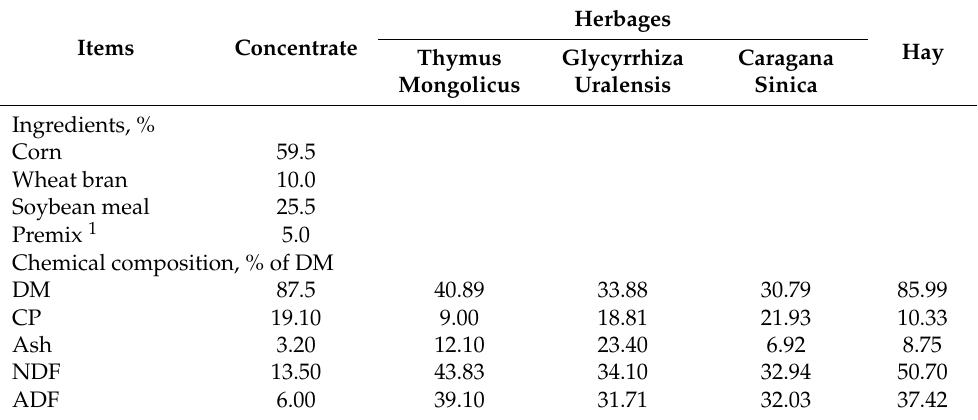
Table 2. Ingredients and chemical composition of concentrate, herbages, and hay